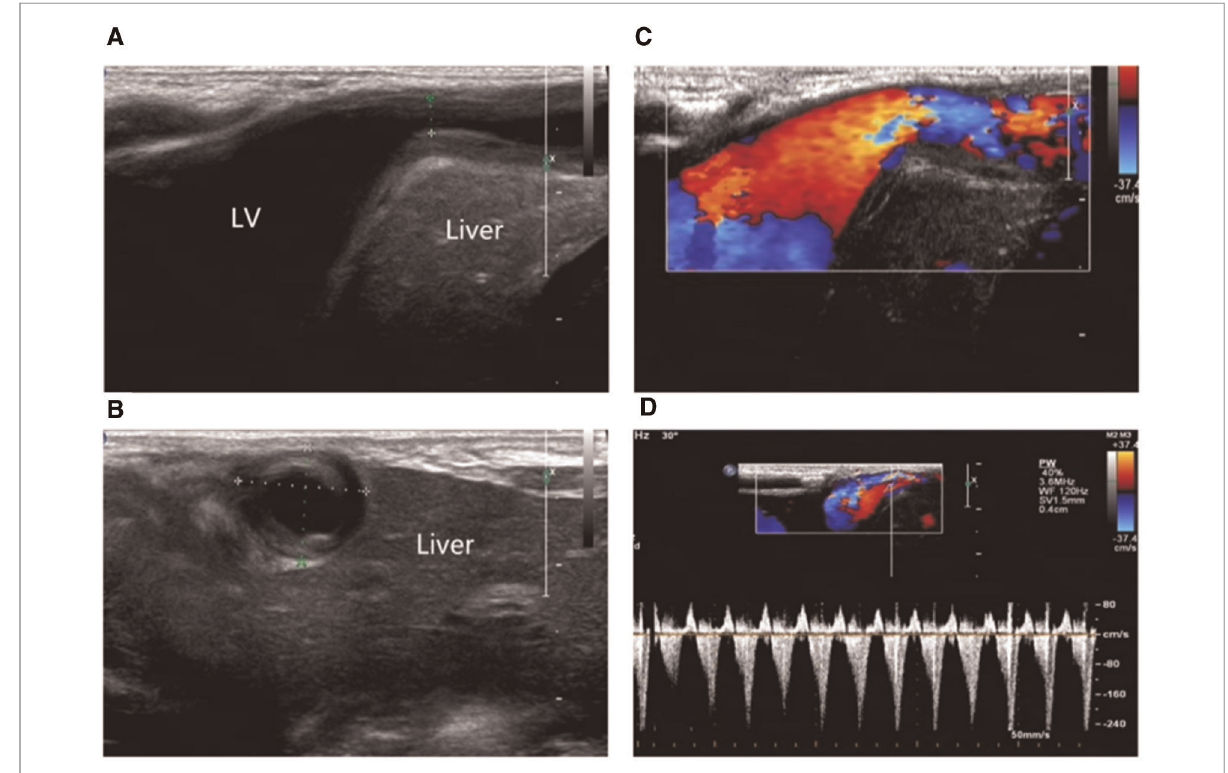
FIGURE 1 ( A ) Ventricular diverticulum in the front of the liver connecting to the apex of the left ventricle with a narrowed neck. ( B ) The left ventricular diverticulum is located between the liver and the anterior abdominal wall. ( C, D ). Blood fl ow signal in the diverticulum neck